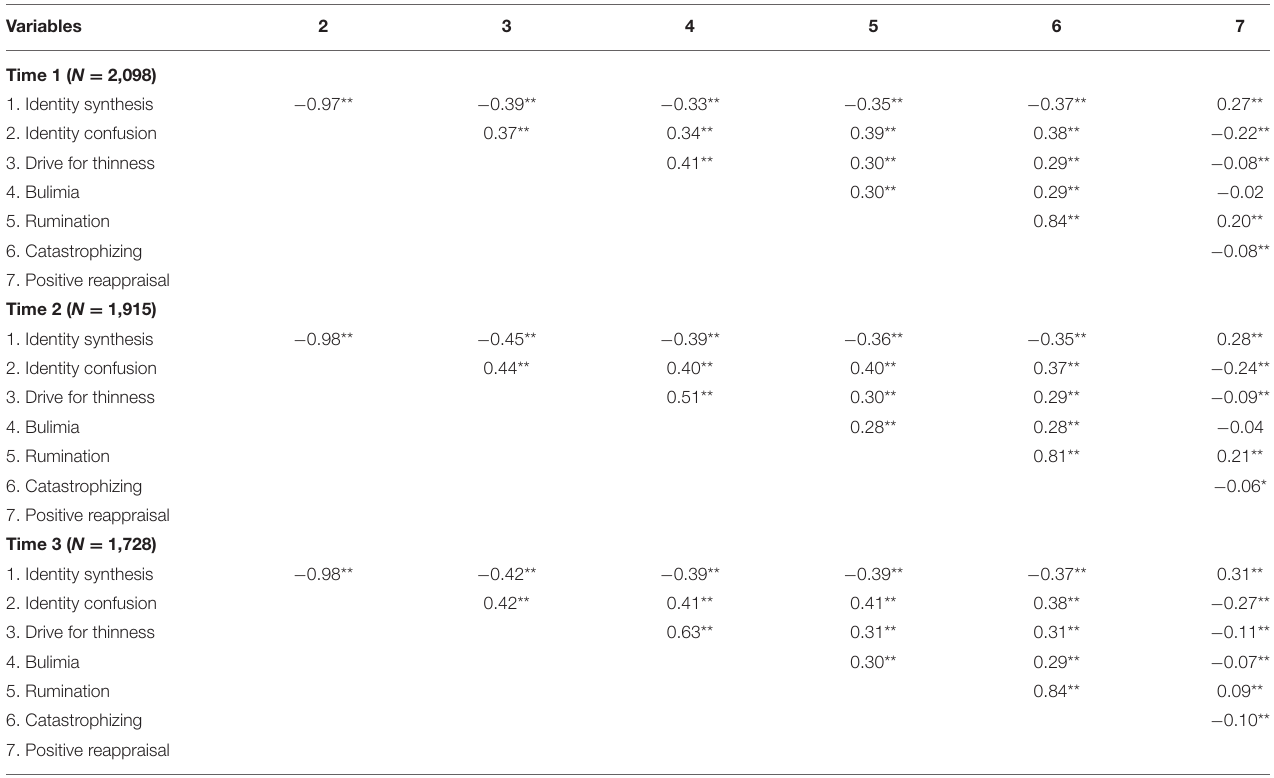
TABLE 2 | Within-Time Correlations Among the Study Variables.